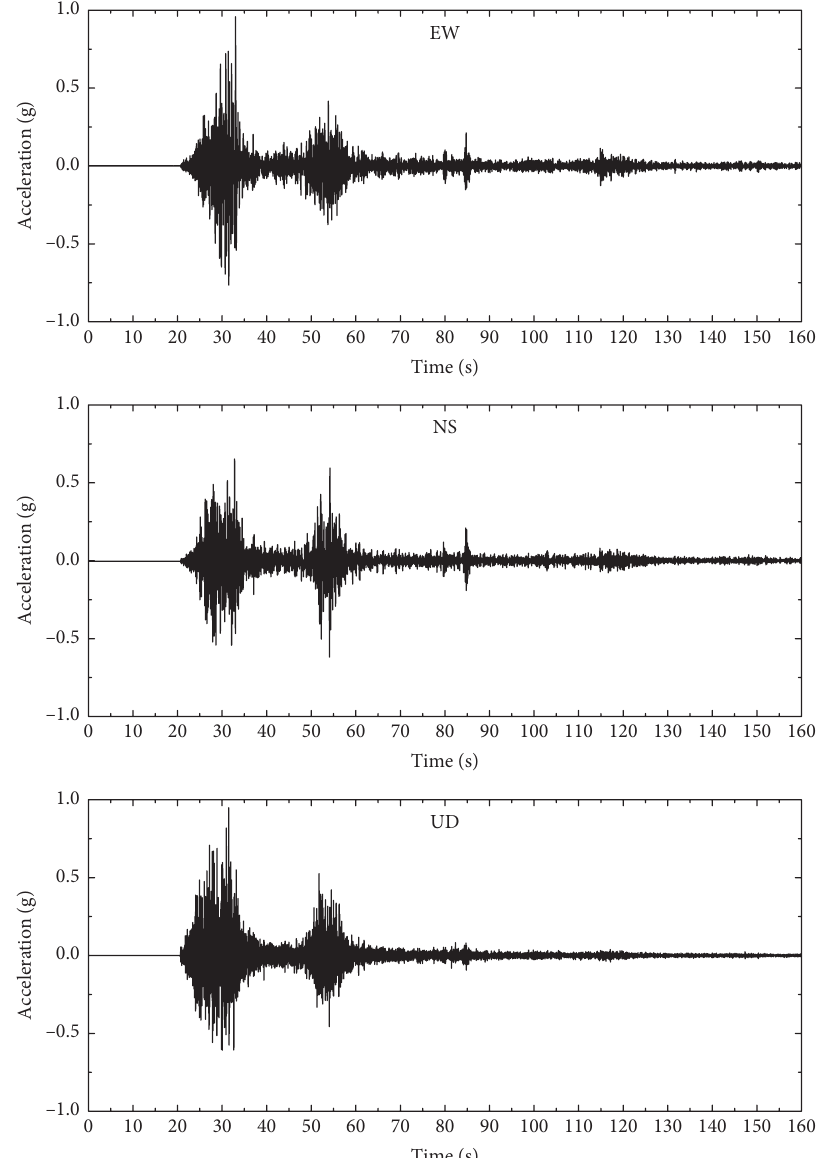
Figure 5: Acceleration time histories of Wolong records.